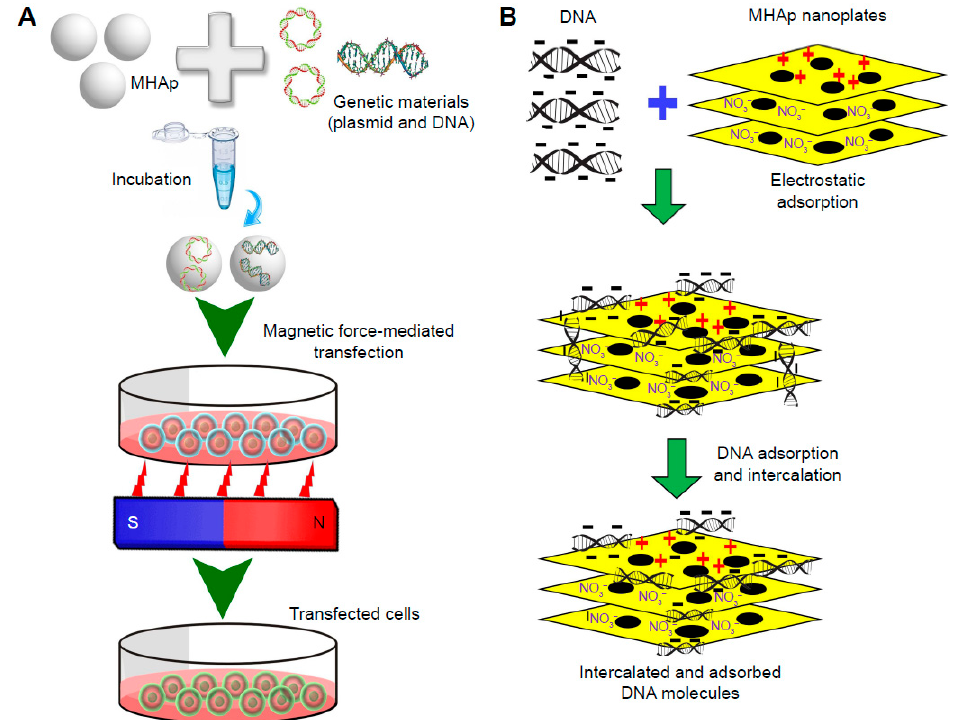
Figure 7. Magnetofection for gene delivery: ( A ) schematic representation of the process and ( B ) schematic illustration of DNA loading into lamellar magnetic hydroxyapatite (MHAp) nanoparti- cles for nucleic acid delivery. (Reprinted from [35], license CC BY 3.0.) Table 1. Magnetic biomimetic nanomaterials: structure, synthesis, and